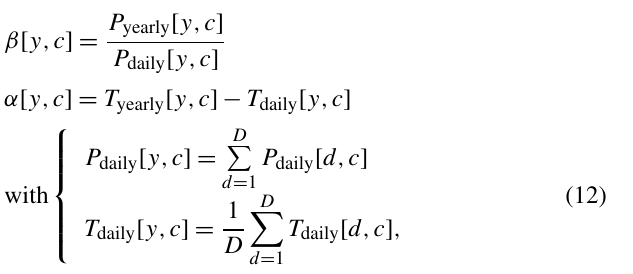
are computed for each year based on the annual values of FYRE Yearly and FYRE